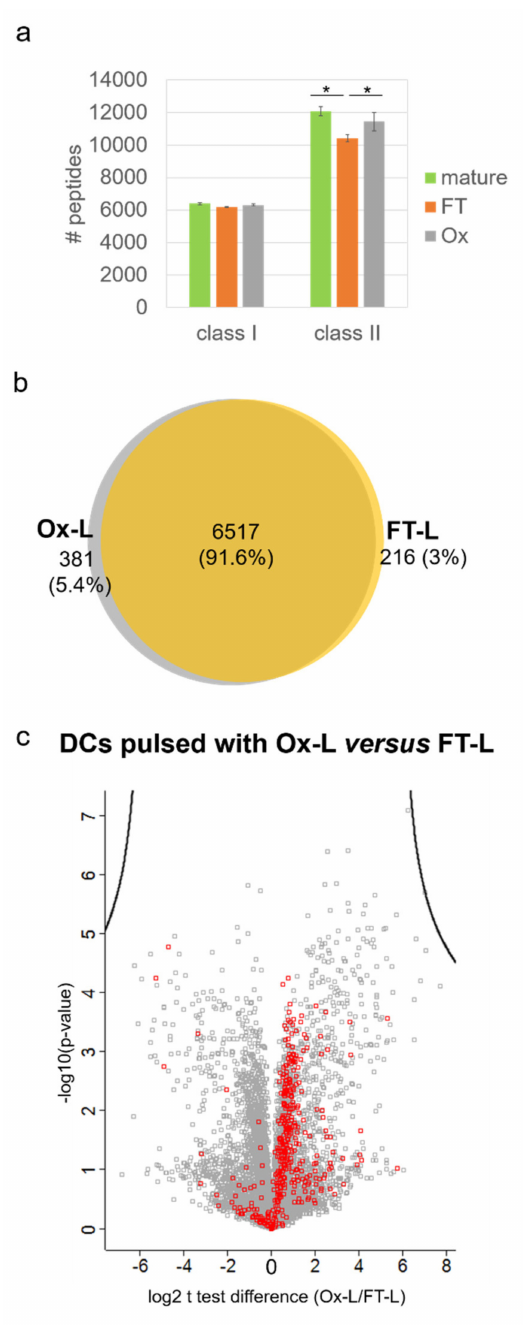
Figure 5. HOCl antigen treatment does not significantly impact on HLA class-I antigen presentation in mo-DCs. Mo-DCs from a healthy donor were loaded with Ox-L or FT-L, or left unloaded (antigen negative control) and subsequently matured in the presence of IFN- γ and LPS. HLA-I and –II peptide were extracted and analyzed by LC-MS / MS. ( a ) Average number of unique peptides isolated from HLA-I and –II complexes from mo-DCs loaded with the indicated antigens ( n = 3 technical replicates). ( b ) Venn diagram reporting the overlap between the number of unique peptides isolated from HLA-I complexes from mo-DCs loaded with the indicated antigen source. ( c ) Volcano plot representation of t test analysis comparing HLA-I peptide intensities in mo-DCs loaded with Ox-L versus FT-L; each point represent one peptide plotted by log2 fold change versus minus logarithm of the q -value (Benjamini-Hochberg corrected p -value), with a cuto ff value of 0.05; red squares indicate peptide containing ox-Met residues. * p <